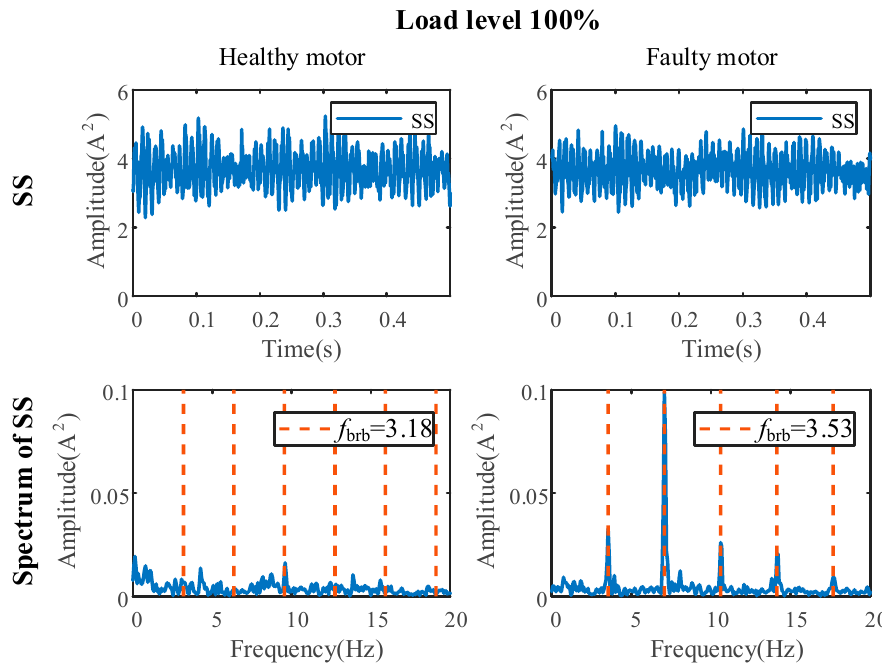
Figure 4. The SS signal and its spectrum of healthy motor and faulty motor at 100% load.